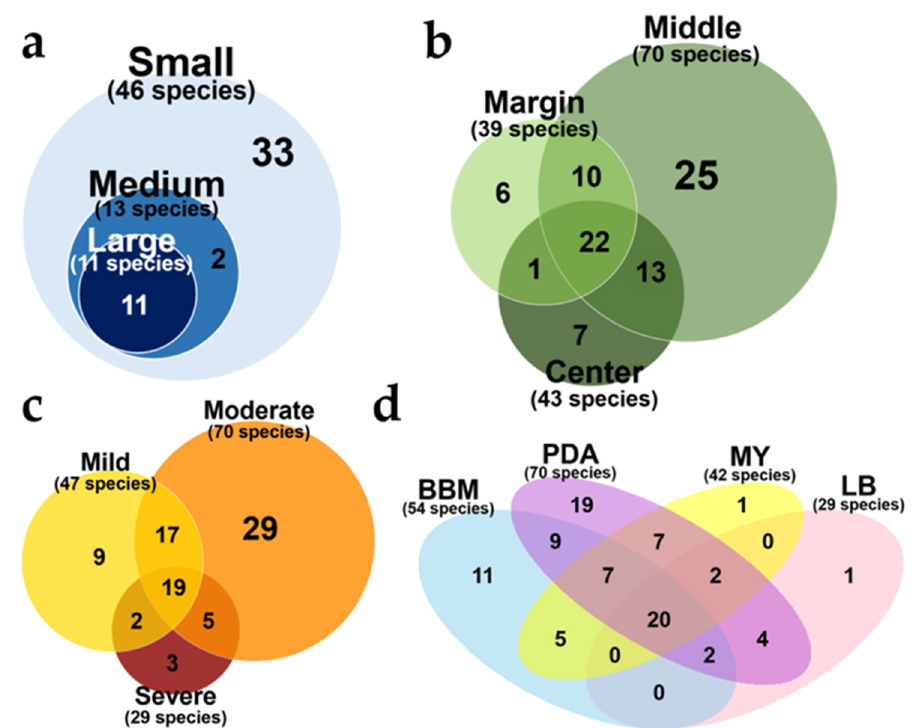
Figure 5. Venn diagrams showing relation among ELF communities from thallus fragments of different sizes ( a ), from different thallus parts ( b ), after different sterilization ( c ), and on different media ( d ).